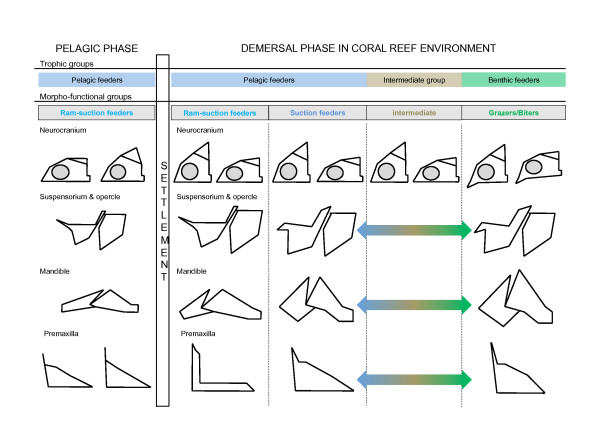
Schematic representation of trophic diversity and morpho-functional disparity throughout ontogeny of damselfishes. See the text for details. Arrows express gradient of shapes between the two extremes of morpho-functional group.